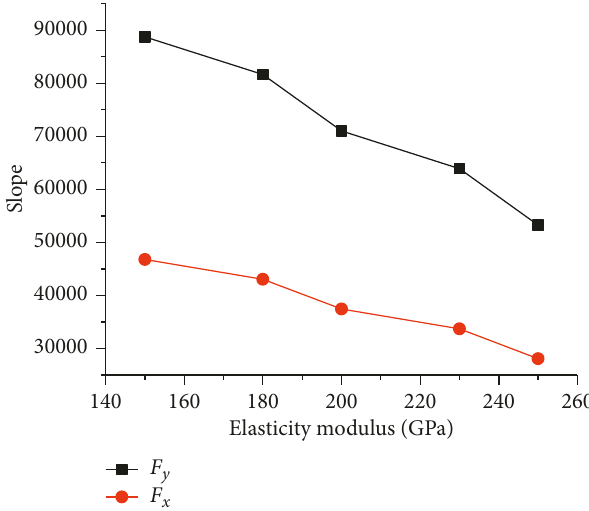
Figure 10: Effects of the elastic modulus on the slope of the loading curve during the elastic deformation